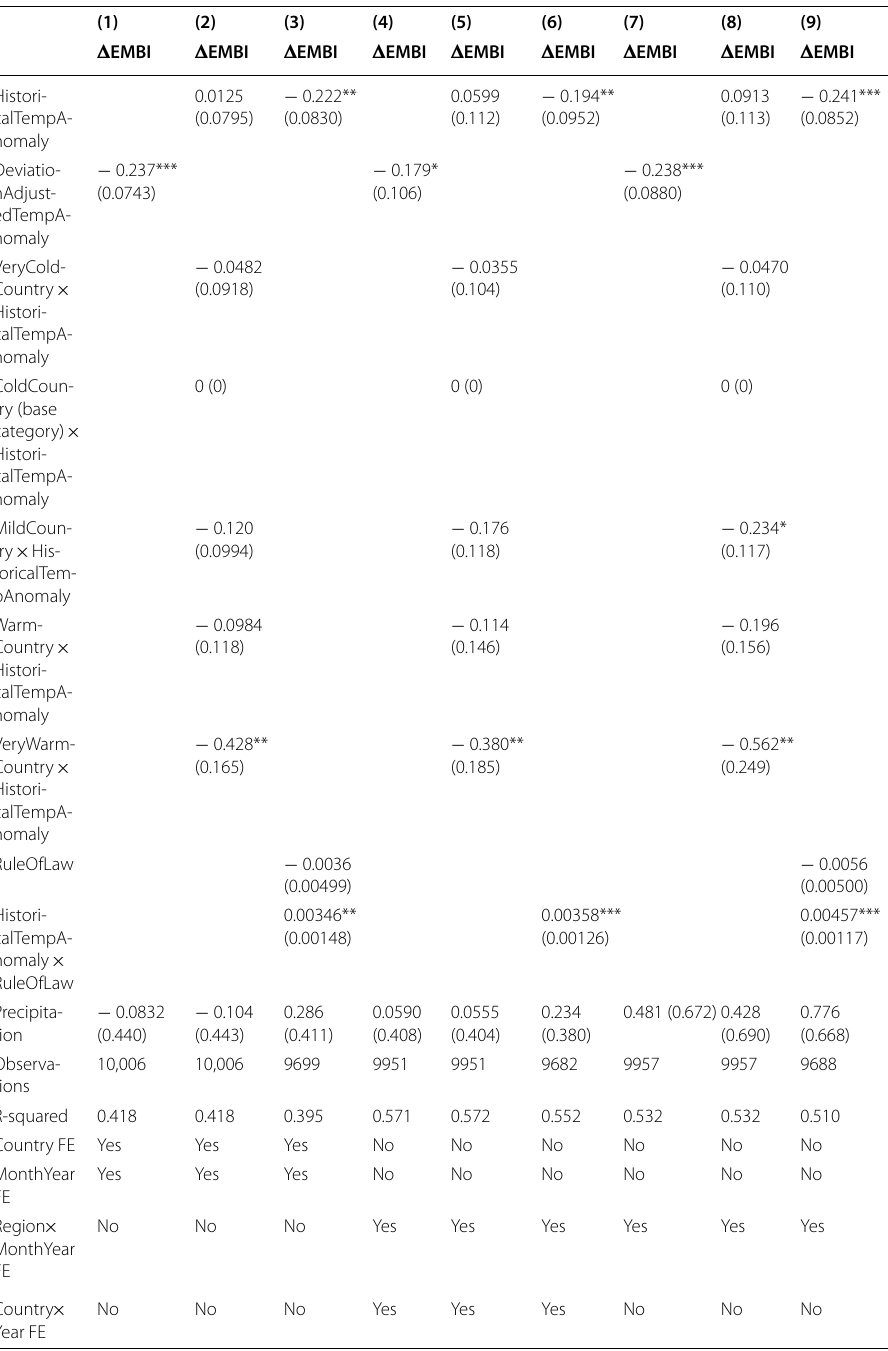
Table 12 Robustness tests: changing fixed effects